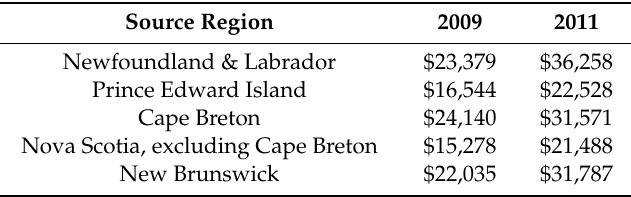
Table 2. T4 Median Earnings from